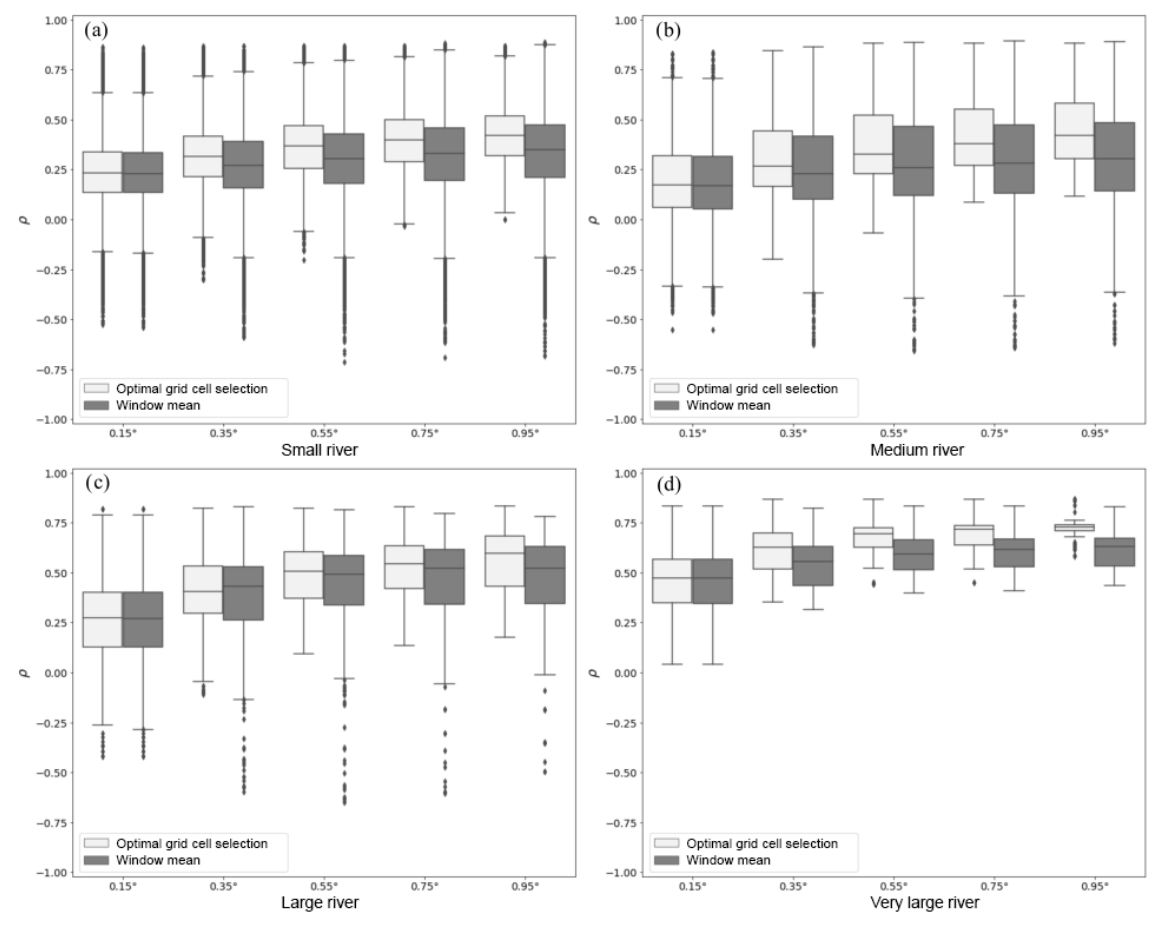
Figure 4. Distributions of Spearman’s rank correlation between GFDS water extent and simulated storage using different window sizes (0 . 15 ◦ × 0 . 15 ◦ , 0 . 35 ◦ × 0 . 35 ◦ , 0 . 55 ◦ × 0 . 55 ◦ , 0 . 75 ◦ × 0 . 75 ◦ , and 0 . 95 ◦ × 0 . 95 ◦ ) and two approaches (light grey: optimal grid cell selection (method A); dark grey: window mean (method B)) in four categories of river flow across the Amazon Basin. Box plots are defined as in Fig.